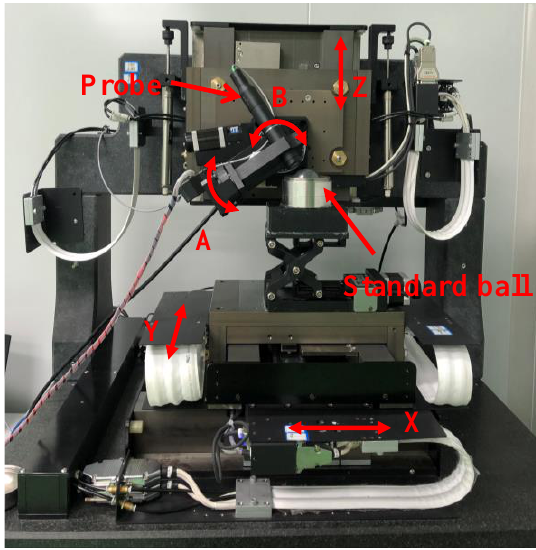
Table 3. The hardware parameters of the measurement system.